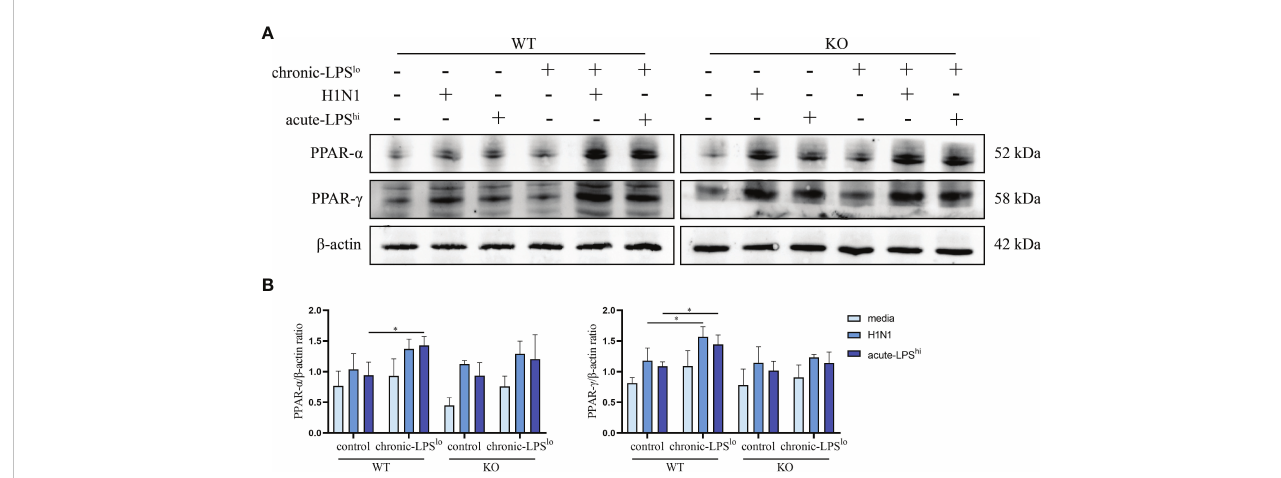
FIGURE 6 Effect of chronic low-dose LPS stimulation on PPAR- a and - g . (A, B) Relative protein levels of PPAR- a and - g in A549 WT and A549 A20-KO cells were detected by western blot. Data are mean ± SD, n = 3. *p< 0.05.